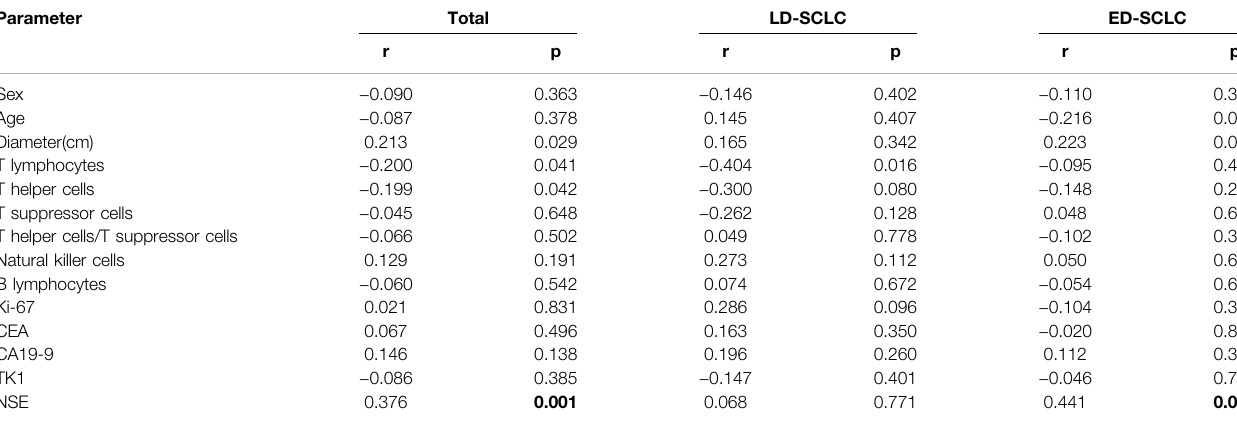
TABLE 2 | Correlation of eHSP90 α and Other Index in SCLC Patients. Parameter